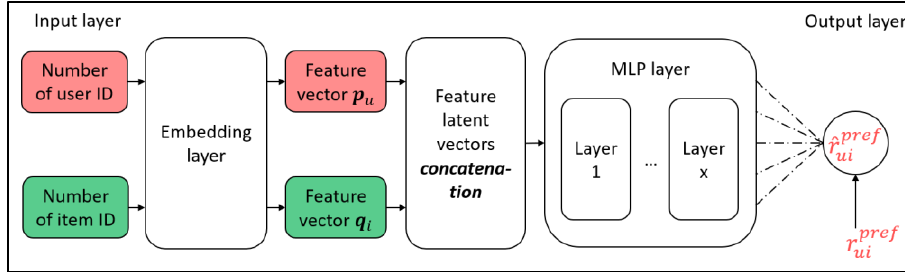
Figure 5. Architecture of the deep learning-based recommender.